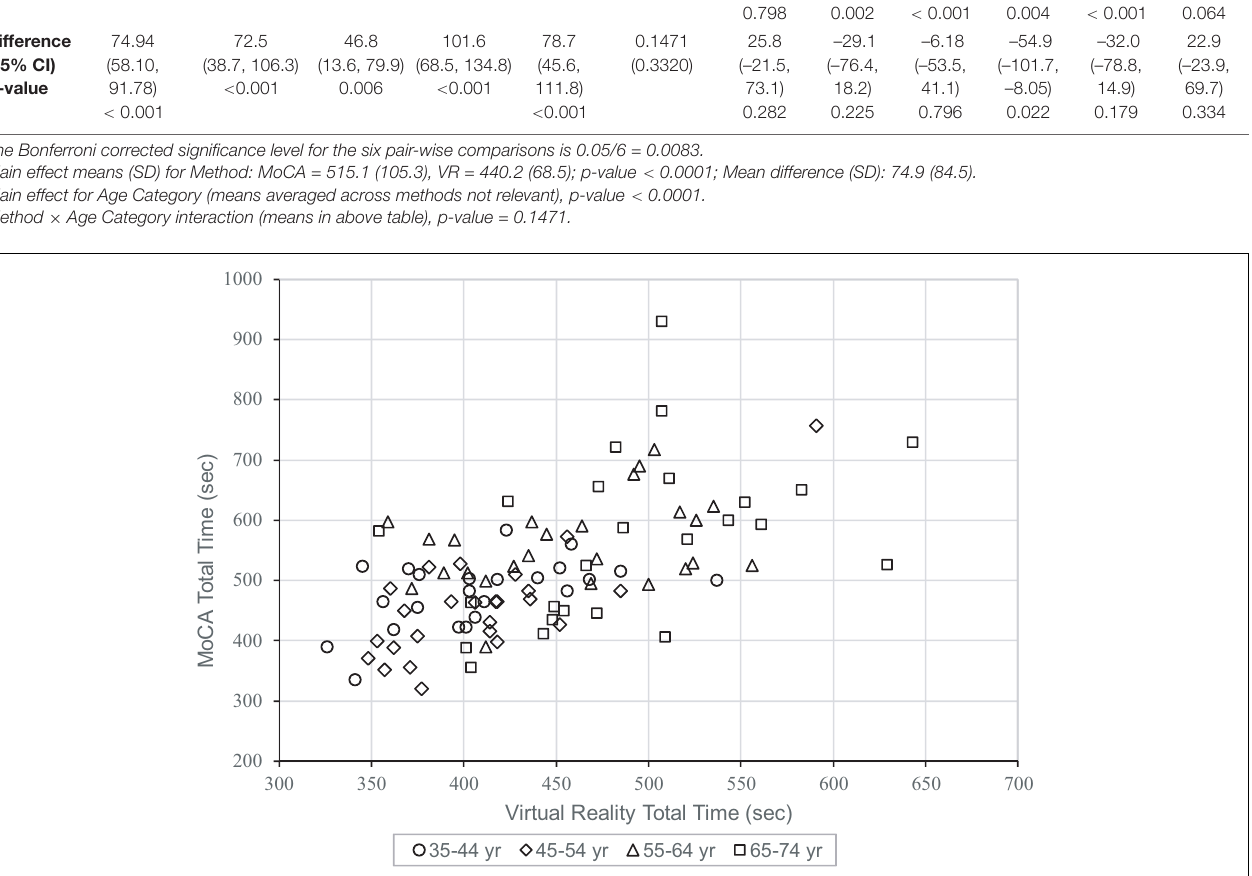
and the CAVIRE tasks was comparable in Groups (1) and (2). In addition, across Groups (2), (3), and (4), there was a greater variability in the total time taken to complete the MoCA, most marked in Group (4), whereas completion time was less variable for the CAVIRE tasks across all age groups, with most consistency in Group (2). Figure 5 shows the difference in mean completion time between the MoCA and the CAVIRE tasks across age groups, again using a box-and-whisker plot.